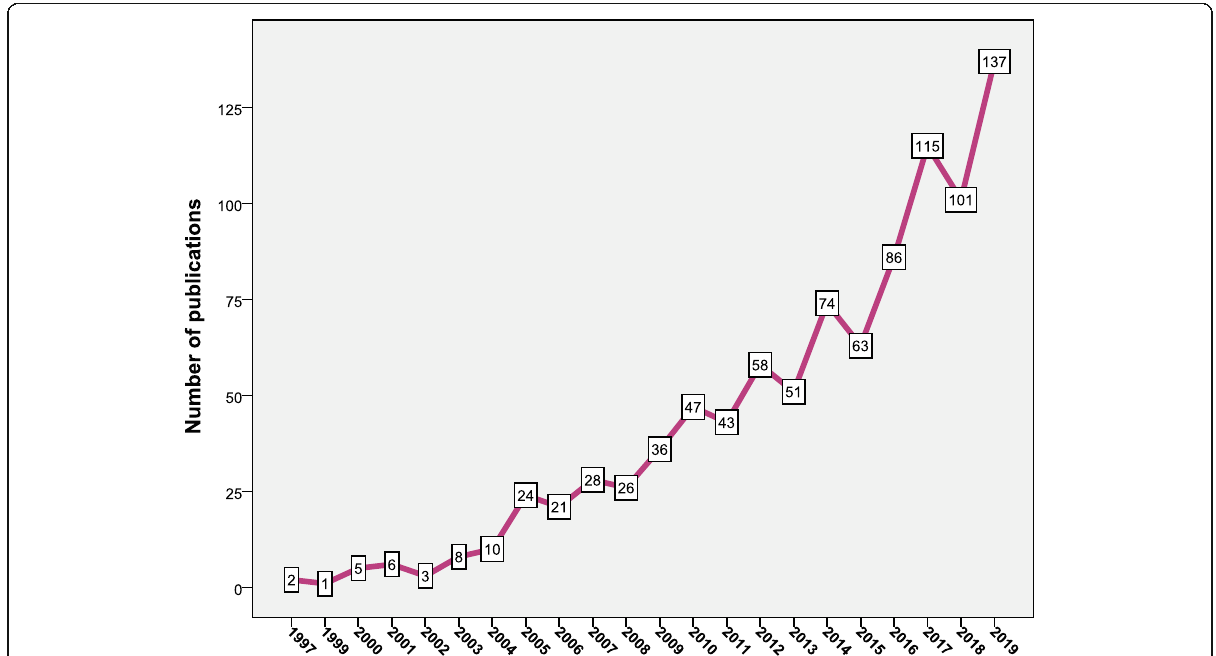
Fig. 1 Annual growth of publications on mental health literacy for the study period from 1900 to 2019. A steep increase was observed in the last decade of the study. More than half of the retrieved papers were published from 2015 to